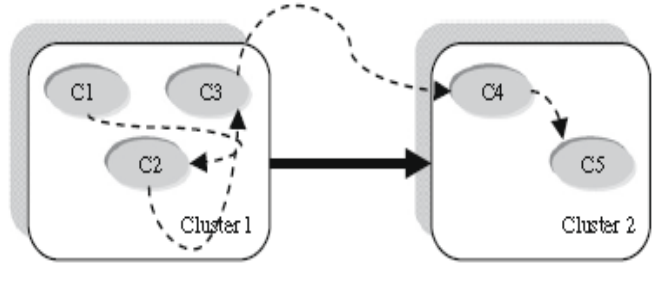
Fig. 1. A network with clusters and connections.